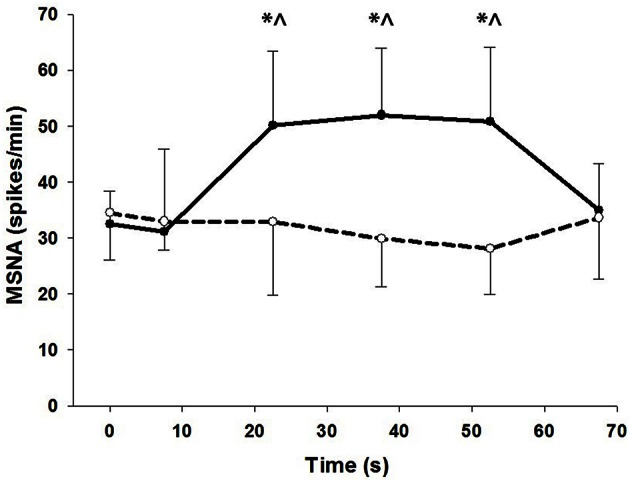
MSNA at 15 s intervals during voluntary (closed circles) and electrically-evoked (open circles) contractions. *Significant main effect of condition (P < 0.03). ∧Significant interaction of time and condition (P < 0.01).